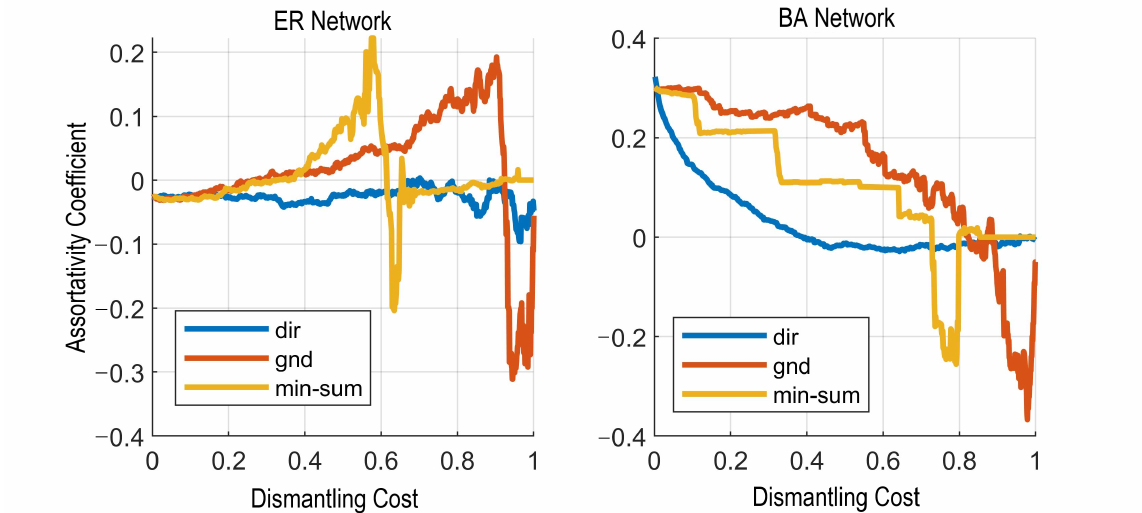
Figure 6. Curve graph of disassembly cost and assortative coefficient of directed ER random network and directed BA random network.